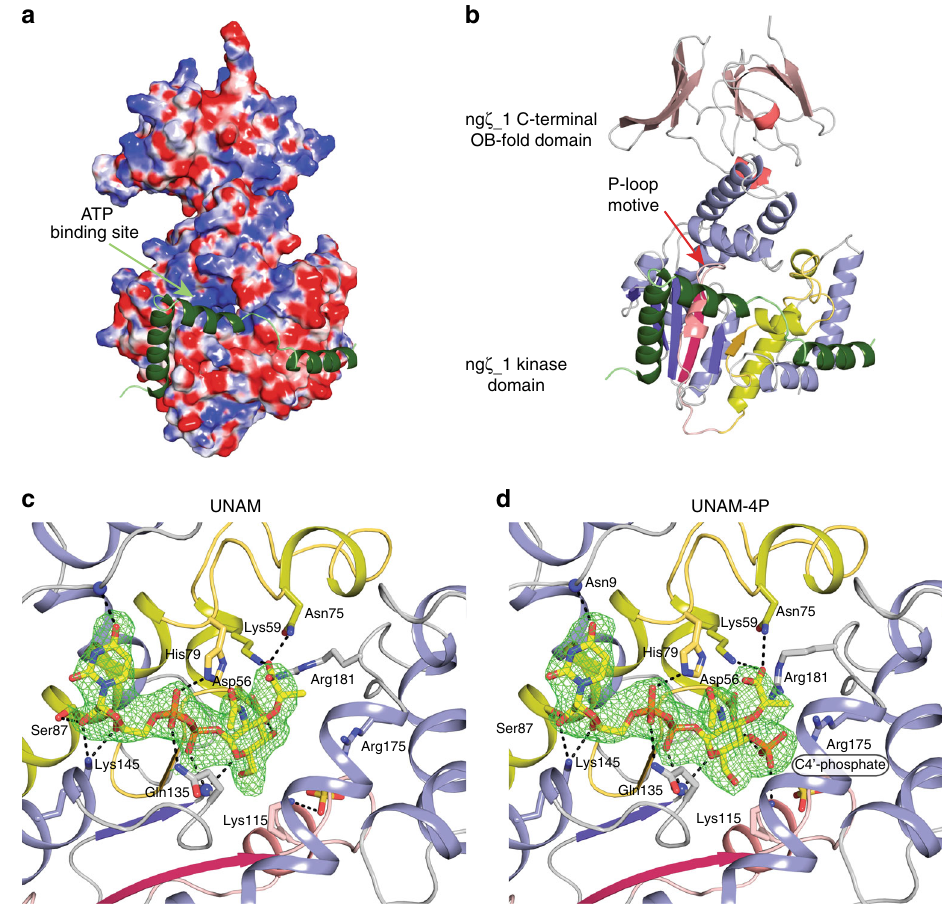
Fig. 3 Structure of the ng ε _1/ng ζ _1 TA complex and substrate binding mode. a Surface representation of ng ζ _1 colored according to the electrostatic surface-potential and ng ε _1 depicted as ribbon model (forest-green). b Ribbon representation of ng ζ _1 at the same orientation as in a . Structural elements involved in topological rewiring are highlighted in red (strand)/pink (helix) and dark-yellow (strand)/yellow (helix). The C-terminal OB-fold domain is colored in red. Coloring is performed similar as in Supplementary Fig. 1. c , d Close-up view of the active site of ng ζ _1 with the bound UNAM ( c ) and UNAM- 4P ( d ) molecules shown as stick model. Fo-Fc electron density map contoured at 3 σ with the ligand omitted before re fi nement is shown as a